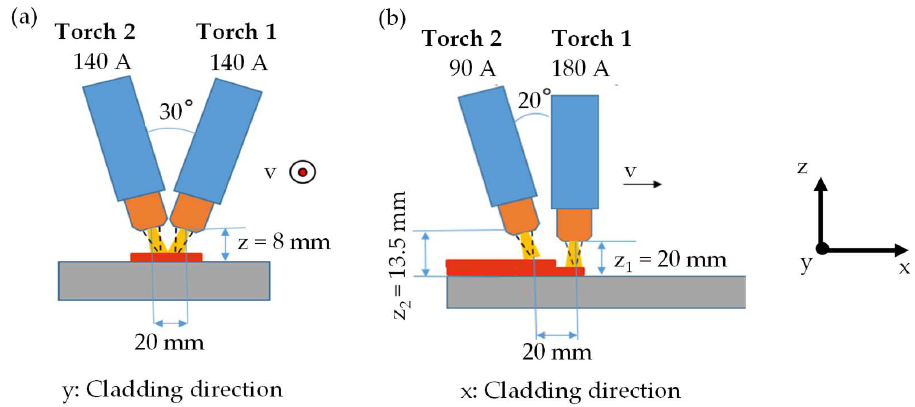
Figure 5. Parameters of the torches for ( a ) parallel configuration tandem PTA, ( b ) series configuration tandem PTA.